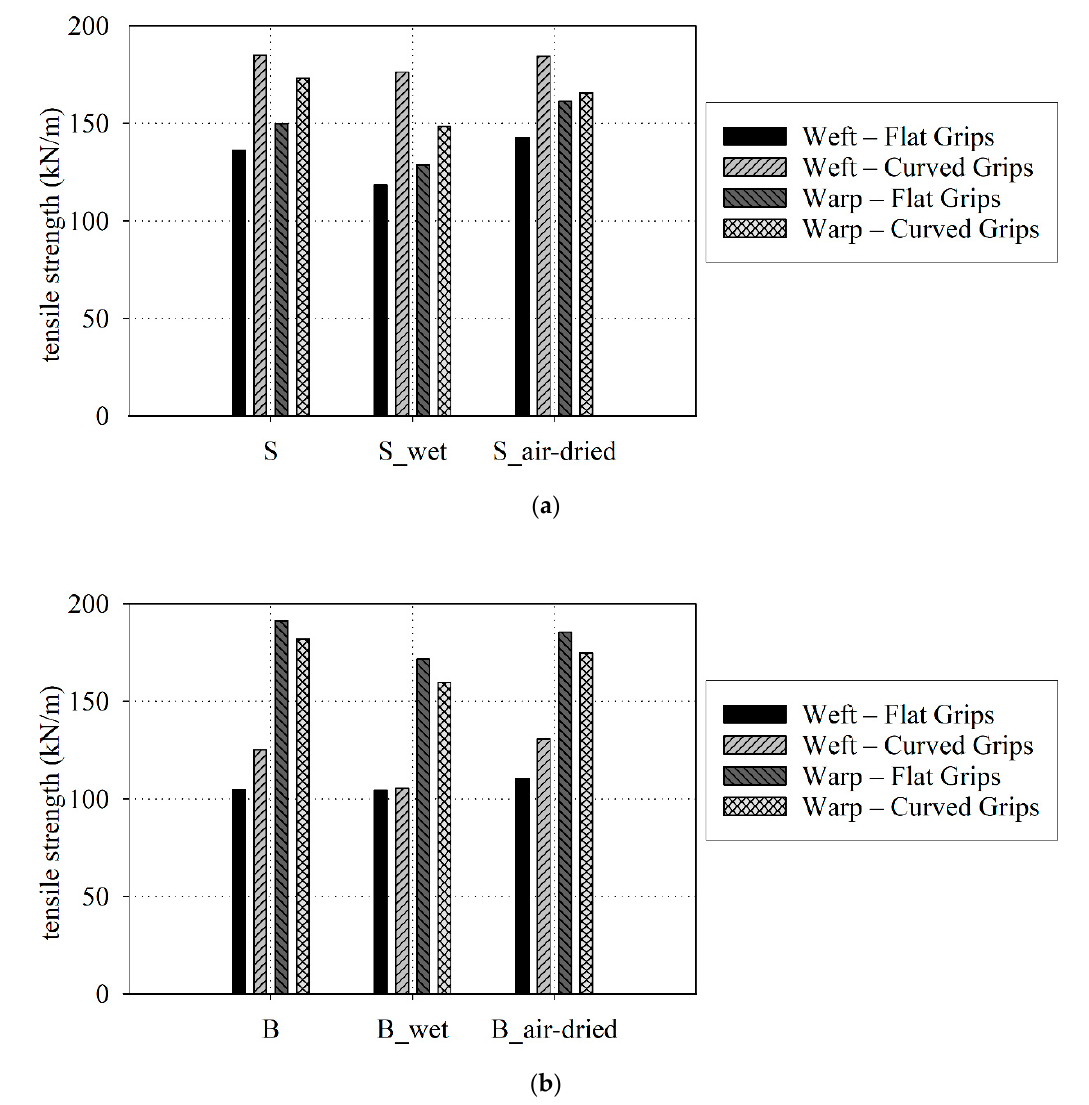
Figure 6. Tensile strength: ( a ) S type fabric; ( b ) B type fabric.